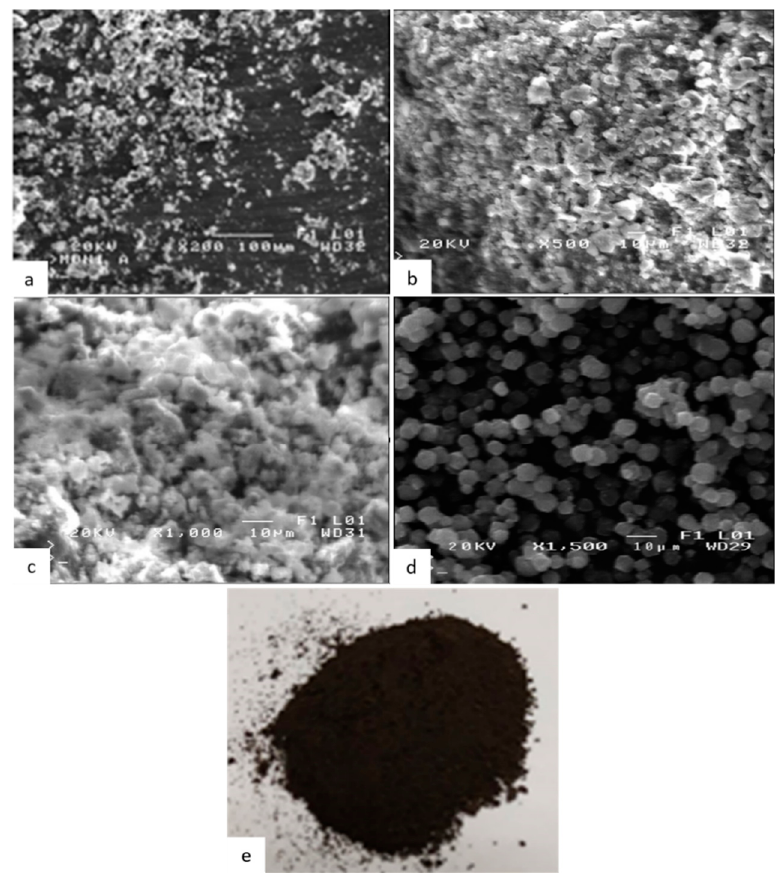
Figure 4. Scanning electron microscopy (SEM) analysis on the particles produced ( a ) zoom × 200, ( b ) zoom × 500, ( c ) zoom × 1000 and ( d ) pure zeolite-X synthesized and ( e ) microscopical view of the synthetized